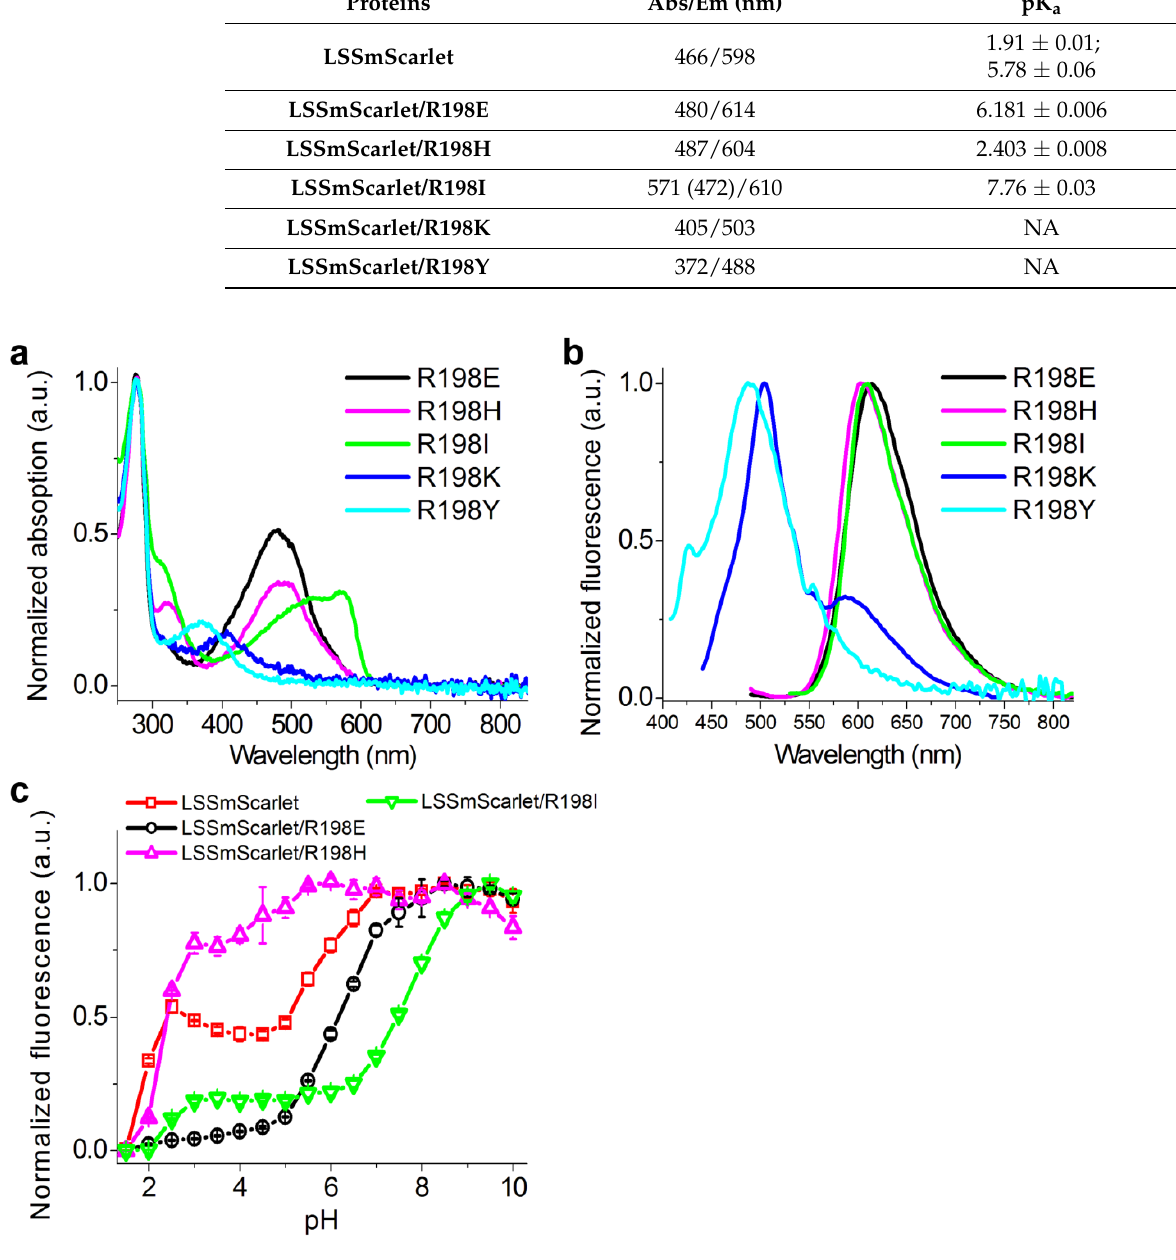
Figure 8. Spectral properties and pH stability for the purified LSSmScarlet mutants with substitutions at position 198. ( a ) Absorption spectra for LSSmScarlet mutants in PBS buffer at pH 7.40. ( b ) Emission spectra for LSSmScarlet mutants in PBS buffer at pH 7.40, excited at absorption maximum. ( c ) pH stability of LSSmScarlet and its mutants. Table 4. In vitro properties of the LSSmScarlet and its mutants at 198 position. Minor peaks are shown in parentheses. Standard deviations are shown. NA, not applicable.